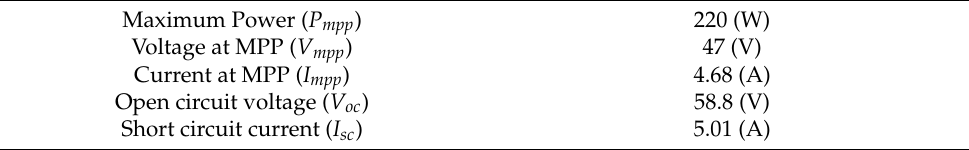
Table 4. The characteristics of PV array.